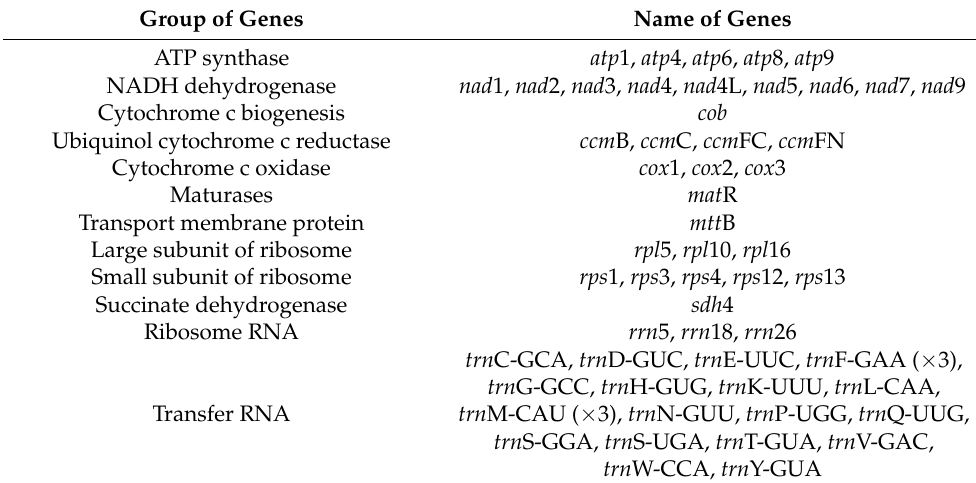
Table 2. Gene composition in the mitochondrial genome of C. speciosa . Group of